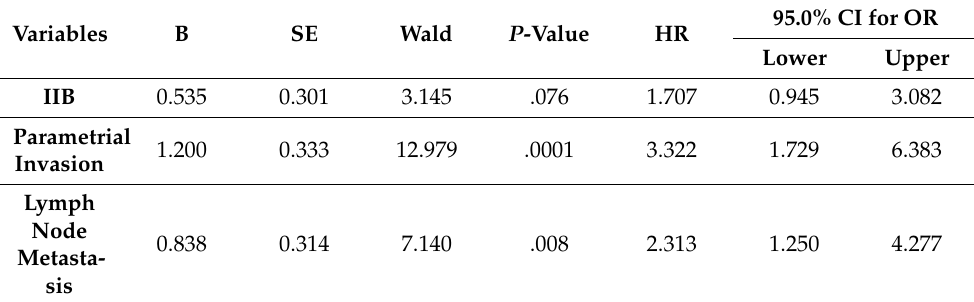
Table 2. Multivariate Cox proportional hazard regression analysis of predictors of overall